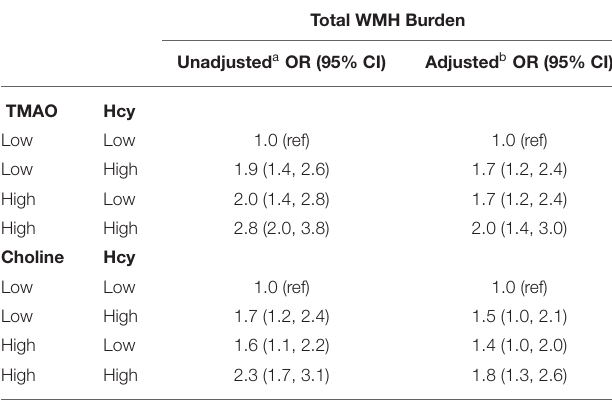
TABLE 3 | Relationships between plasma TMAO or choline concentrations, plasma Hcy levels, and the risk of a higher total WMH burden in the context of plasma Hcy